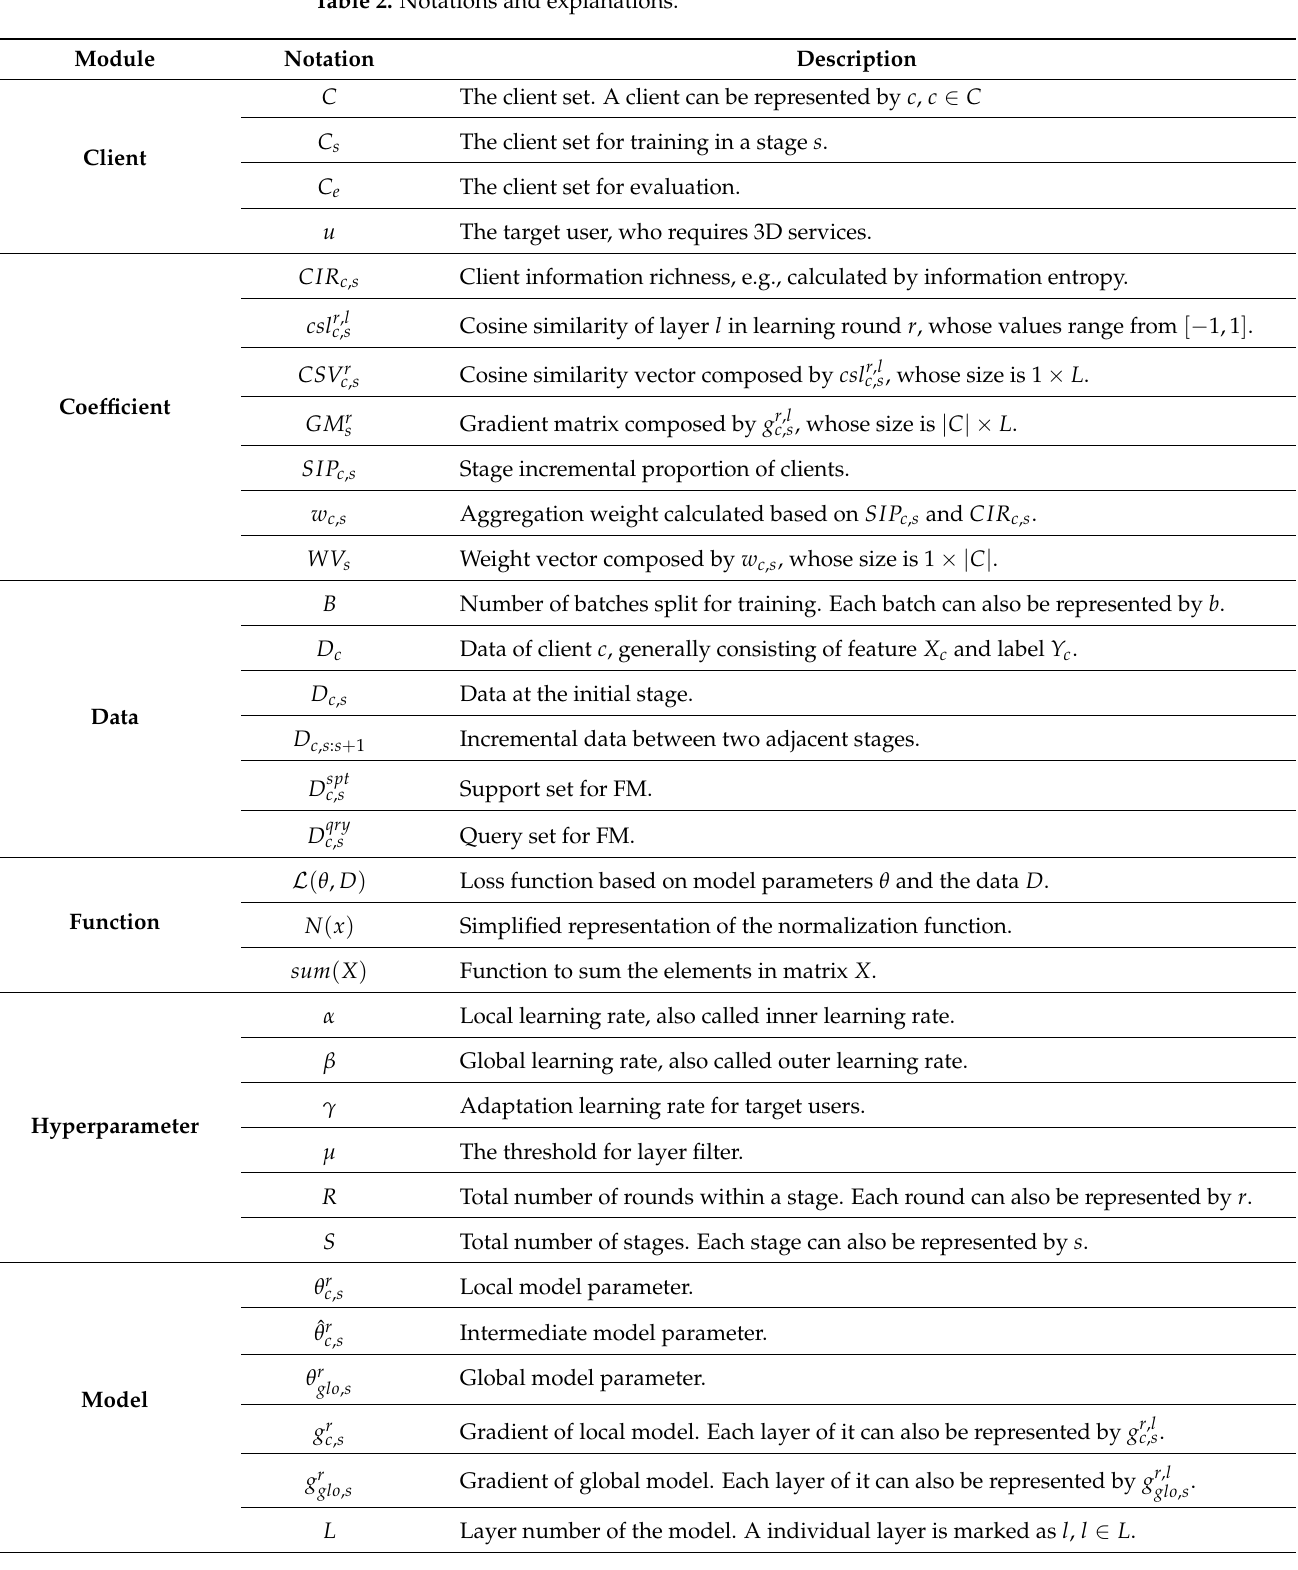
Table 2. Notations and